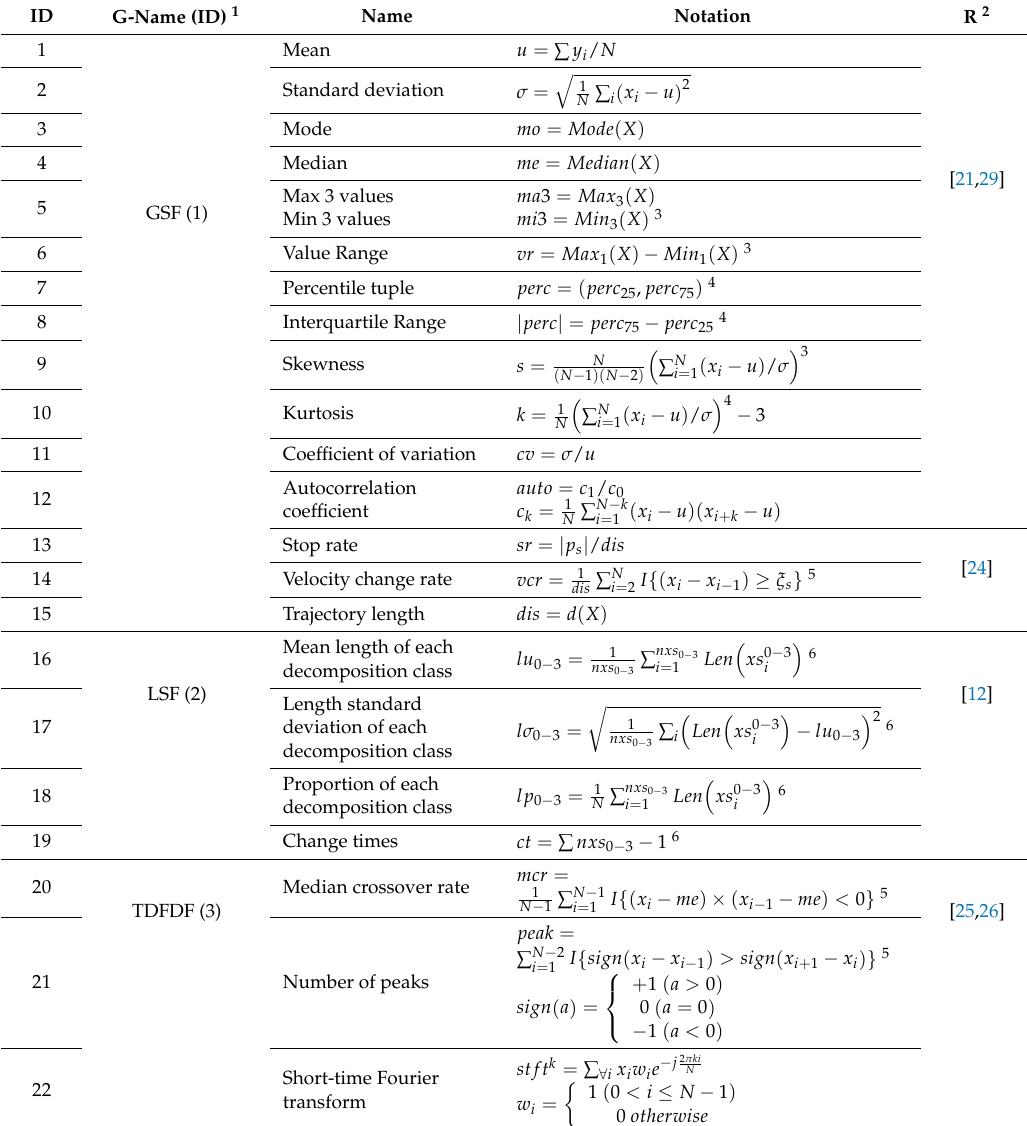
Table 1. Features of Global Statistical Features (GSF), Local Statistical Features (LSF) and Time-Domain and Frequency-Domain Features